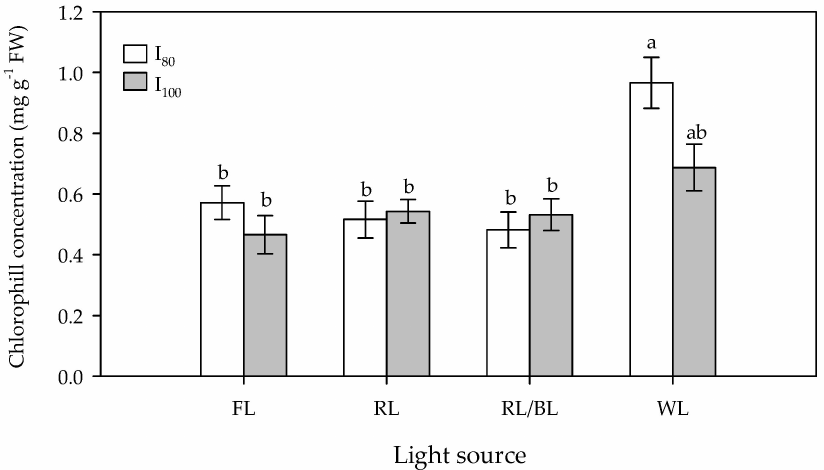
Figure 5. Effect of light source (FL = Fluorescence, RL = predominantly Red, RL/BL = Red/Blue, and WL = White lights) and light intensity (I 80 and I 100 = 80 and 100 µ mol m − 2 s − 1 , respectively) on total chlorophyll concentration (mg g − 1 ) of in vitro pineapple leaves. Different letters indicate significant differences for p < 0.05, error bars indicate standard error of the